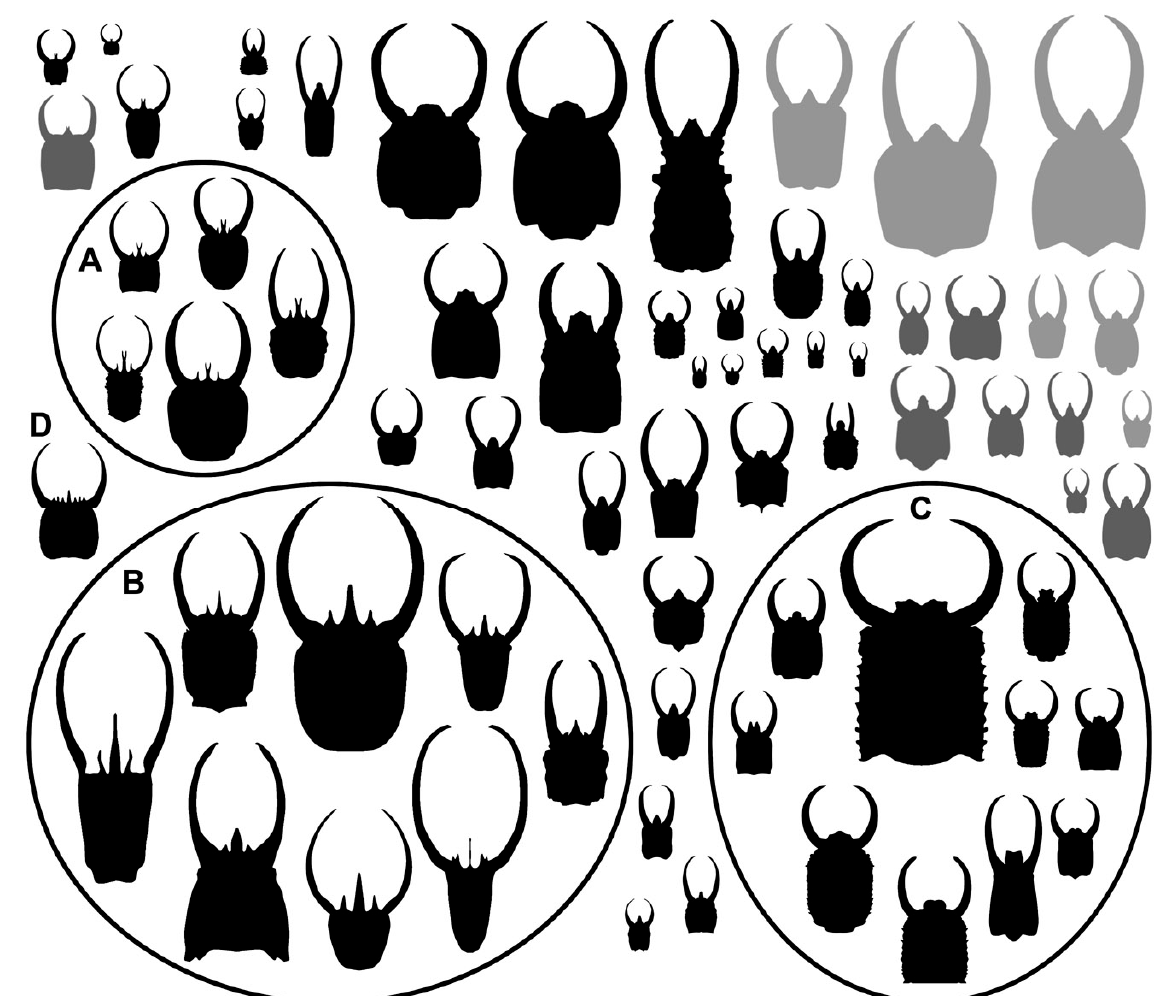
Figure 37. Size comparison of head + stylet shapes of all specimens for which a size indication was available, depicted at the same scale. ( A ) Trident-bearing larvae with bifurcated middle spines. ( B ) Trident-bearing larvae without a bifurcation in the middle spines. ( C ) Larvae with very broad labra. ( D ) Trident-bearing larva with additional spines.